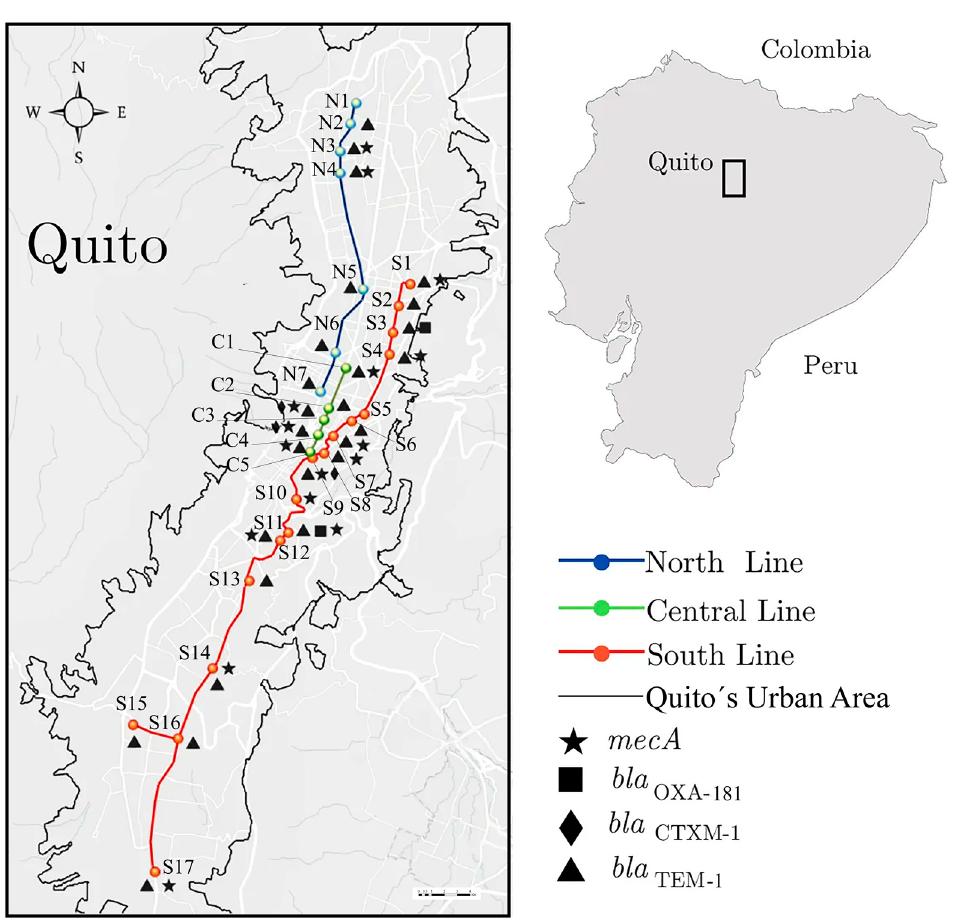
Figure 1. Map of Quito’s Public Transport (QTP) showing North, Central, and South lines. Black icons show the presence of bla TEM-1 , bla CTX-M1 , bla OXA-48 , and mecA genes found in each station from eDNA.